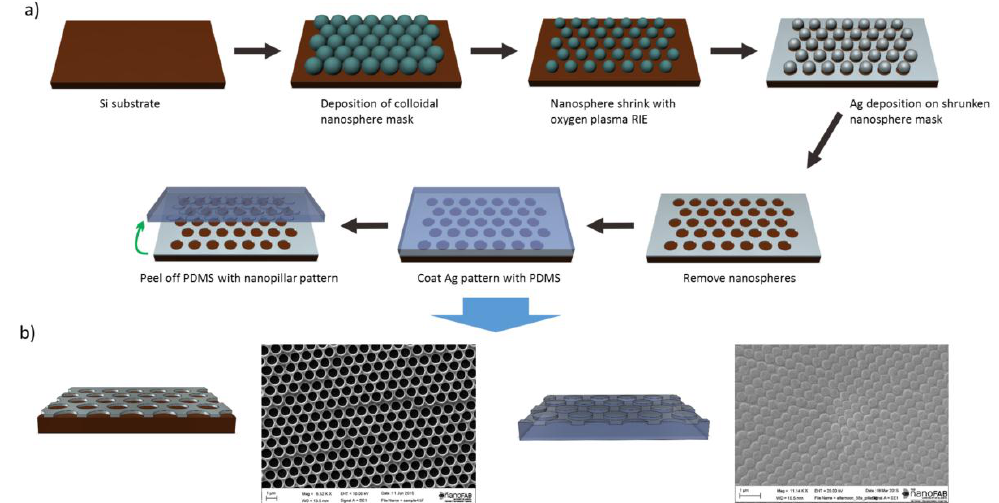
Figure 1. ( a ) The proposed process flow for fabrication of nanocavity and nanopillar arrays. ( b ) Top view scanning electron microscope (SEM) images and cross-sectional schematic of the nanocavity (left) and nanopillar (right) arrays fabricated using the proposed process.